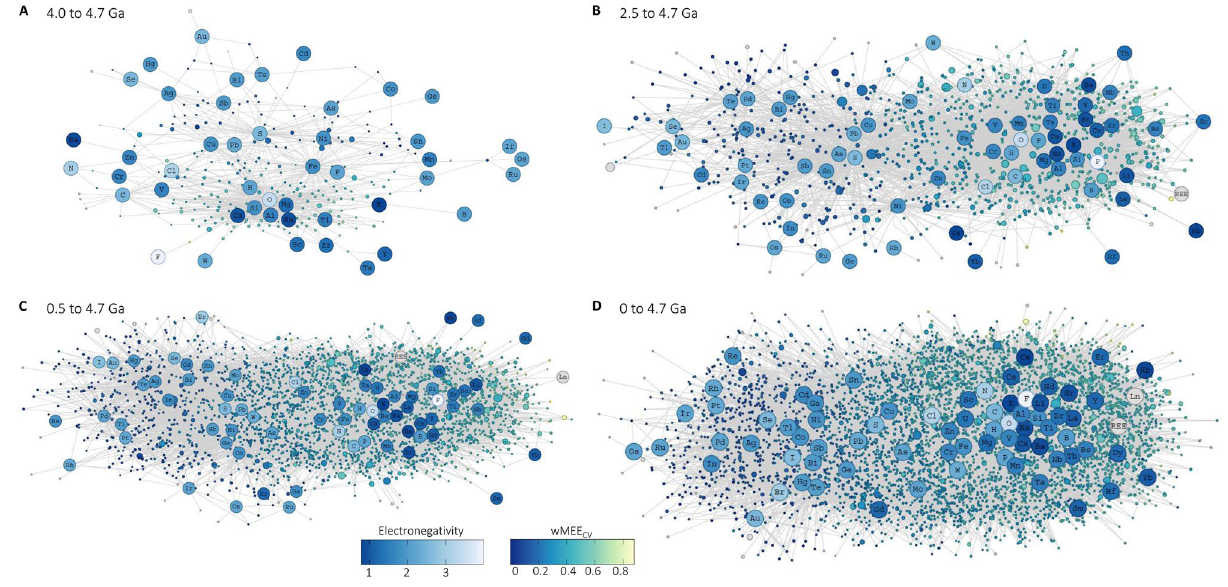
Figure 3. Full mineral chemistry network expansion through geologic time. Bipartite mineral chemistry network containing all minerals and their constituent elements with maximum known ages at ( A ) 4.0–4.7 Ga; ( B ) 2.5–4.7 Ga; ( C ) 0.5–4.7 Ga; ( D ) 0–4.7 Ga. Network lines (“edges”) connect minerals to all of their constituent elements. Element nodes are colored by Pauling scale electronegativity 3 and minerals nodes are colored by weighted Mineral Element Electronegativity Coefficient of Variation (wMEE CV ). Mineral nodes are sized by their number of known localities. Figure created using dragon version 1.1.0 (https:// github. com/ sjspi elman/ dragon).